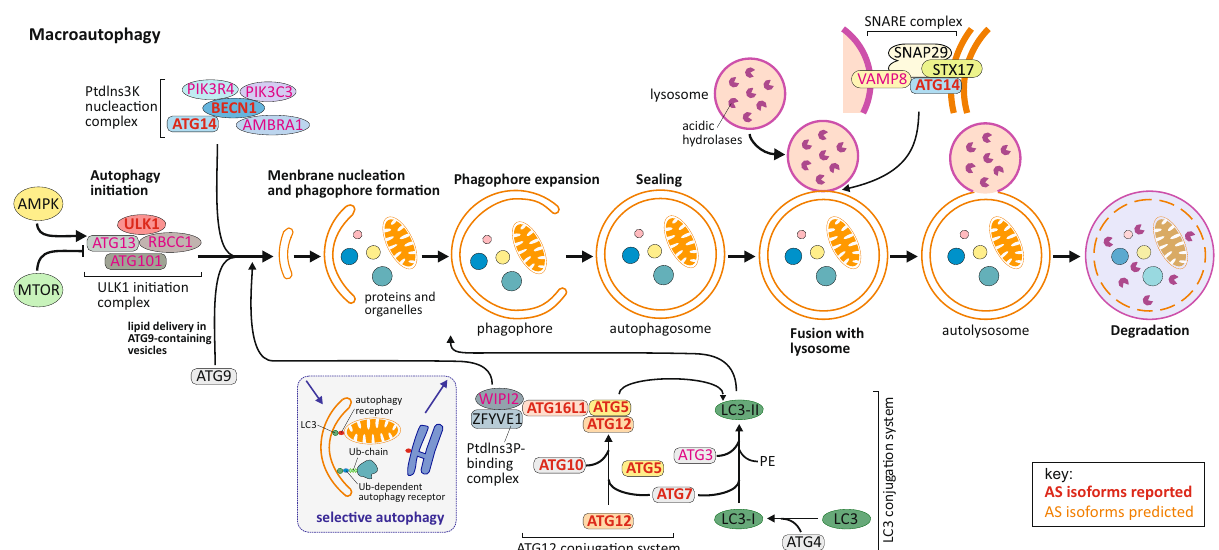
Fig. 1 Macroautophagy machinery with indication of components presenting alternative splice isoforms. Bulk autophagy starts with the stepwise engulfment of cytoplasmic material by the phagophore, which matures into a double-layered vesicle named an autophagosome. AMPK and MTOR promote and repress autophagy induction, respectively, through phosphorylation of ULK1 at distinct residues. The ULK1-containing initiation complex triggers phagophore formation by phosphorylating components of the class III Ptdlns3K nucleation complex. The activated Ptdlns3K nucleation complex generates PtdIns3P, which leads to the recruitment of the effector proteins WIPI2 and ZFYVE1/DFCP1. Two Ubl conjugation systems are part of the expansion process. The ATG12-conjugation system that supports in the formation of ATG12 – ATG5-ATG16L1 ternary complex, which in turn promotes the second conjugation reaction. The second system, the LC3 conjugation system, involves the conjugation of PE to MAP1LC3/LC3. Lipid conjugation converts the soluble processed form of LC3, named LC3-I, into the phagophore membrane-bound LC3-II form. LC3-II functions in phagophore expansion, and in cargo recognition of ubiquitinated proteins and organelles, including upon selective autophagy with the involvement of autophagy receptors and Ub- dependent autophagy receptors (see Box 2 for further details). As a result of membrane expansion and sealing, the autophagic cargo become sequestered within the mature autophagosome which then fuses with a lysosome. A set of SNARE proteins, are essential for the fusion between autophagosomes and lysosomes. ATG14 promotes the SNARE-mediated autophagosome-lysosome fusion. Docking and fusion of the outer autophagosomal membrane with that of the lysosome exposes the inner vesicle to the lysosomal lumen, where acidic hydrolases degrade and recycle the macromolecular components for cellular use. Key: Component of the autophagic machinery with predicted alternative splice isoforms are highlighted with orange text, and those with reported alternative splice isoforms are highlighted with red bold